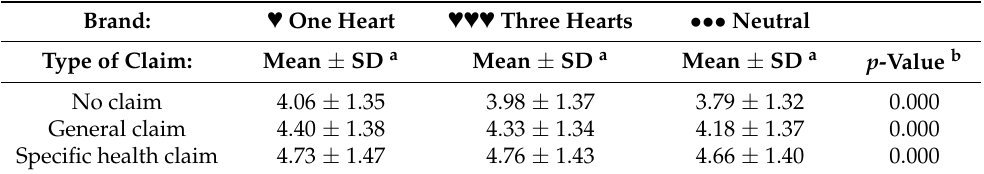
Table 4. Ratings of health impacts of soft drinks labelled with different constructed brands and claims (N =